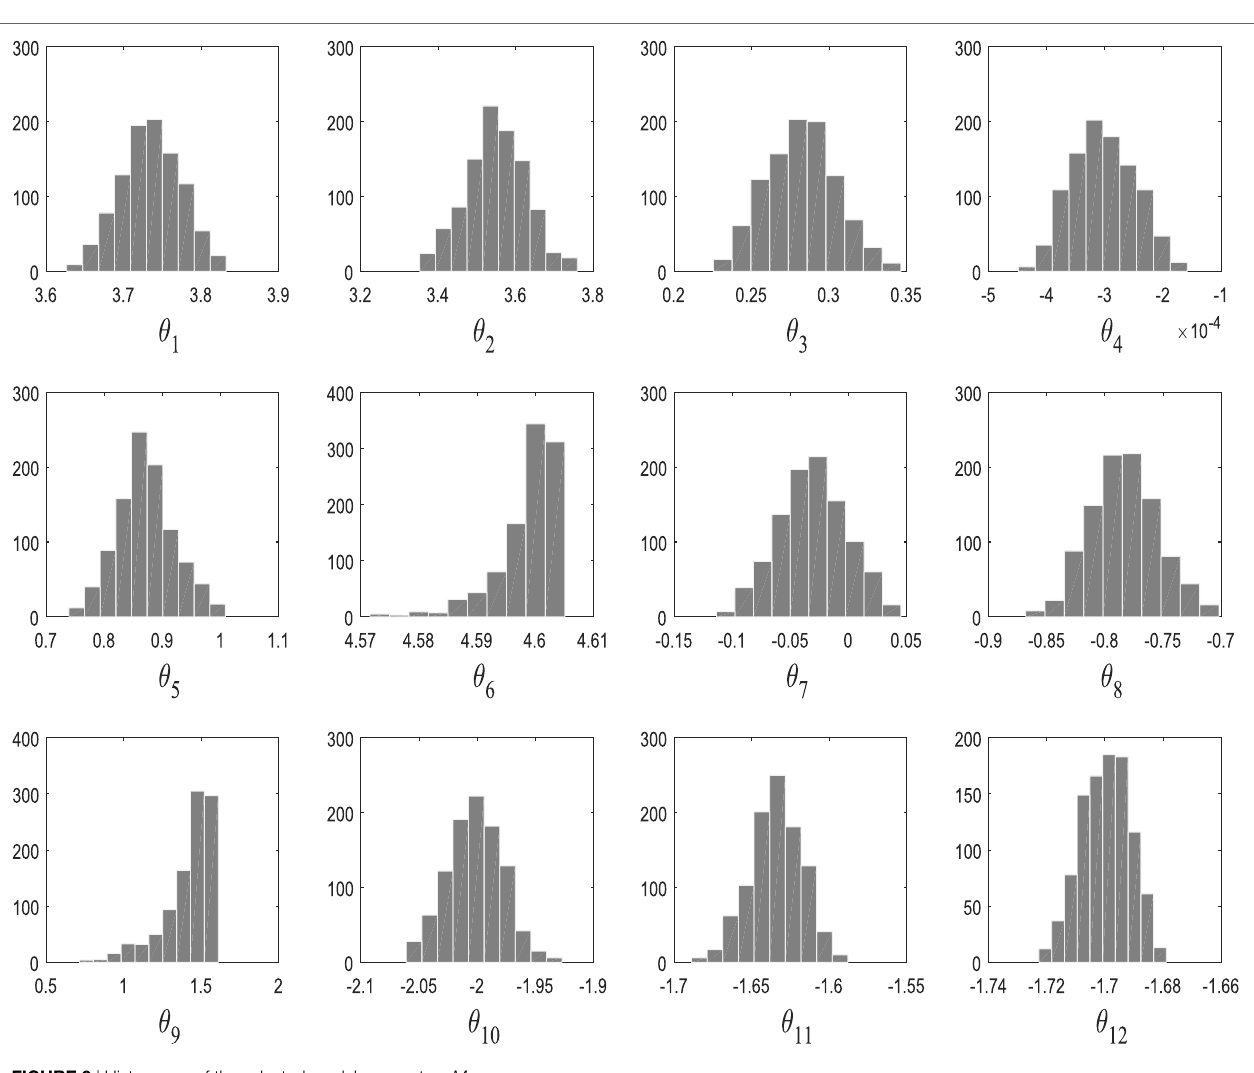
Frontiers in Built Environment |